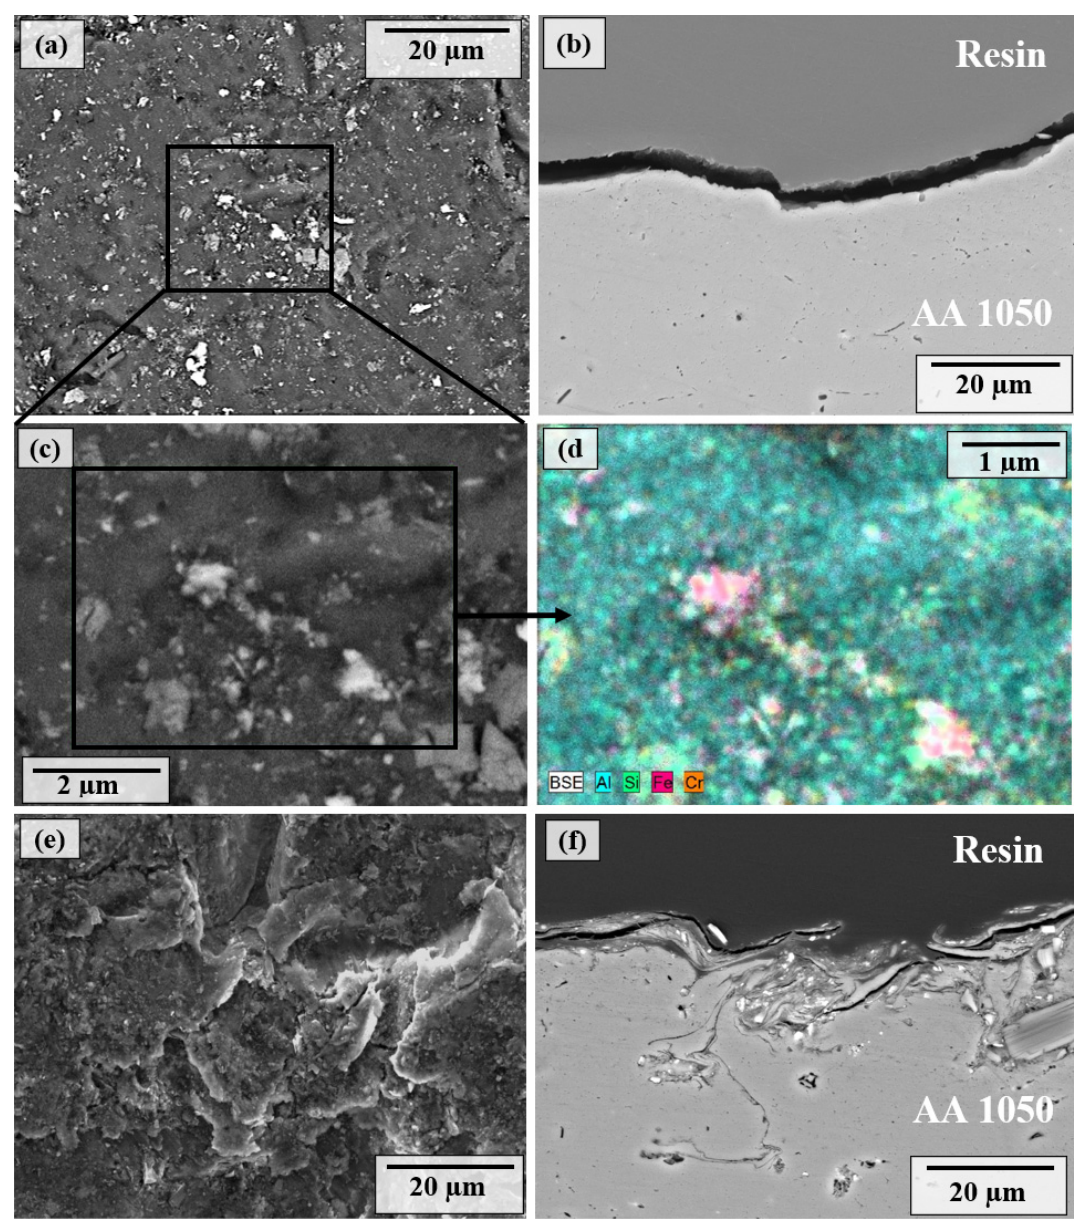
Figure 3. SEM images of ( a ) surface morphologies, ( b ) cross-sectional microstructures, ( c ) high-magnification image at the region of interest, ( d ) EDS analysis of shot-peened AA1050 alloy at 0.1 MPa and 100% cover rate, ( e ) SEM images of surface morphologies, and ( f ) cross-sectional microstructures of shot-peened AA1050 alloy at 0.1 MPa and 1000% cover rate.